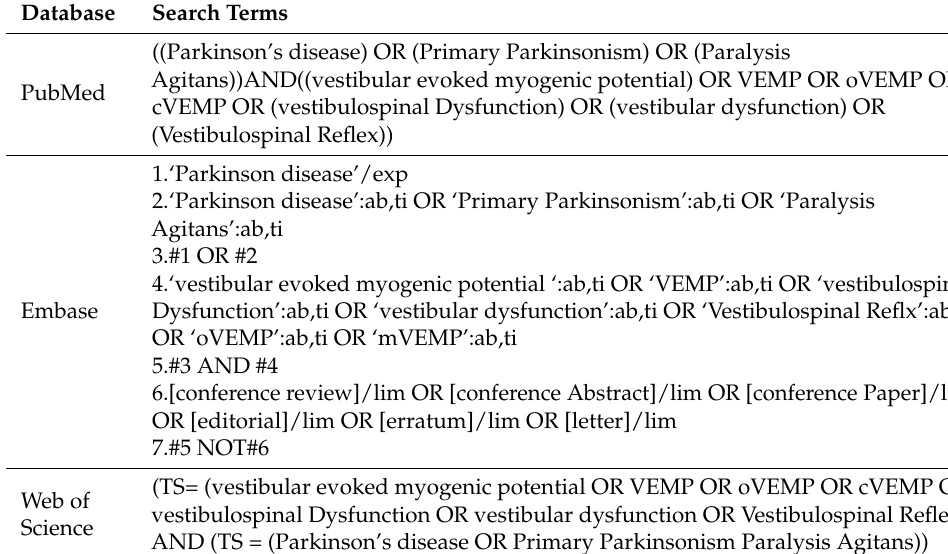
Table A1. Search Terms Used for Each Database.